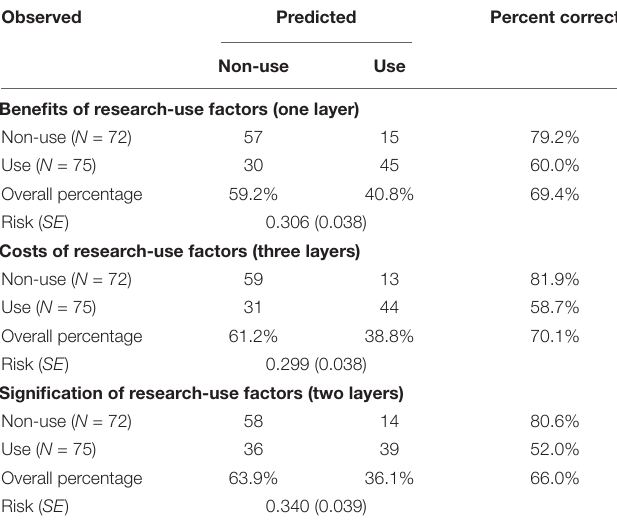
TABLE 6 | Overall case classification prediction accuracy and risk.